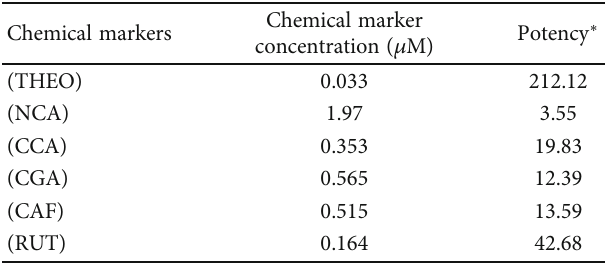
Table 3: E ff ects of compounds/chemical markers at concentration present in the IA extract (at a dose of 3 μ g/mL) on NOx concentrations in the RAW 264.7 macrophages induced by